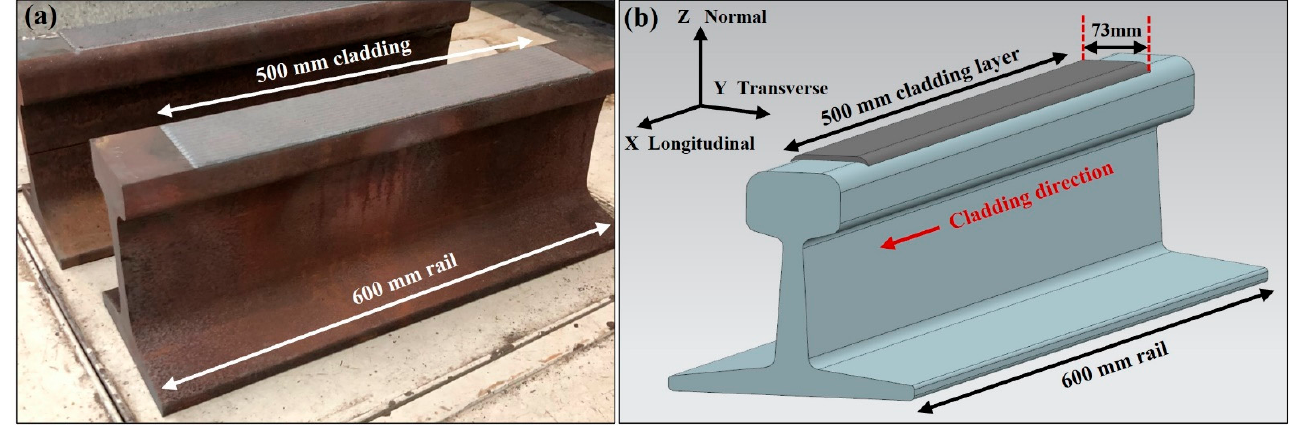
Figure 1. ( a ) Laser-clad hypereutectoid rail used for analysis and ( b ) schematic of a laser-clad rail. Table 1. Chemical composition of the 415SS cladding and hypereutectoid substrate in weight percent